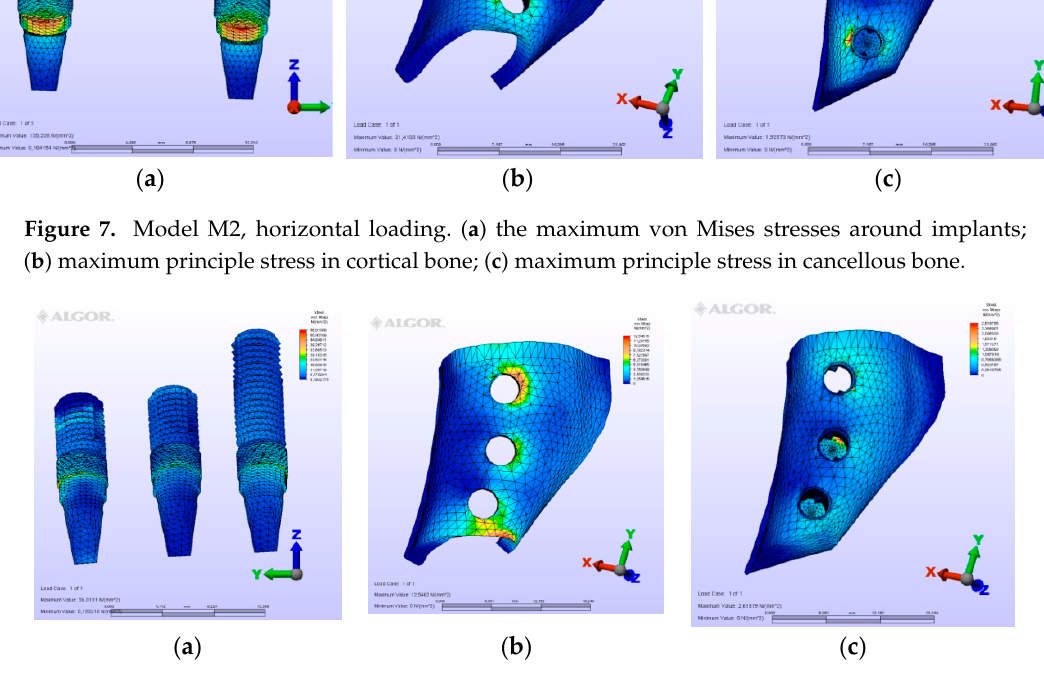
Figure 8. Model M3, axial loading. ( a ) the maximum von Mises stresses around implants; ( b ) maximum principle stress in cortical bone; ( c ) maximum principle stress in cancellous bone.